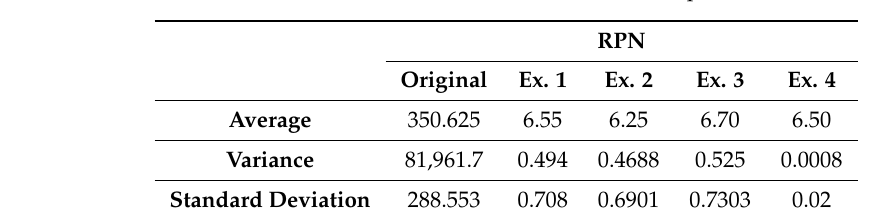
Table 9. Statistical evaluation of the